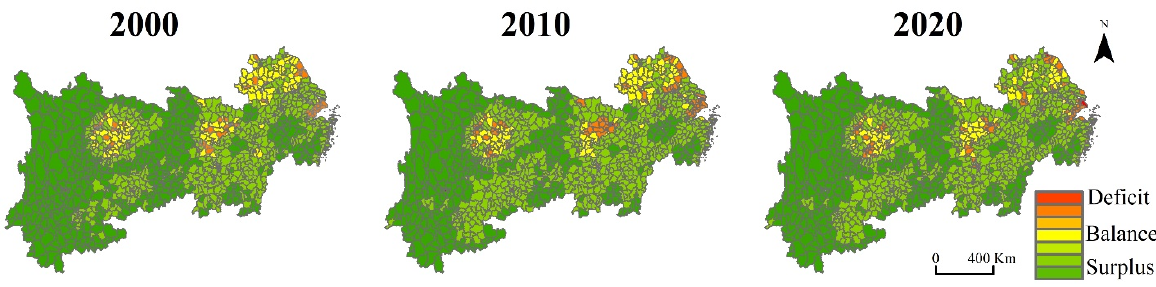
Figure 7. Scatter plot of Moran’s I index between the CESDR and the CUL in the YREB from 2000 to 2020.